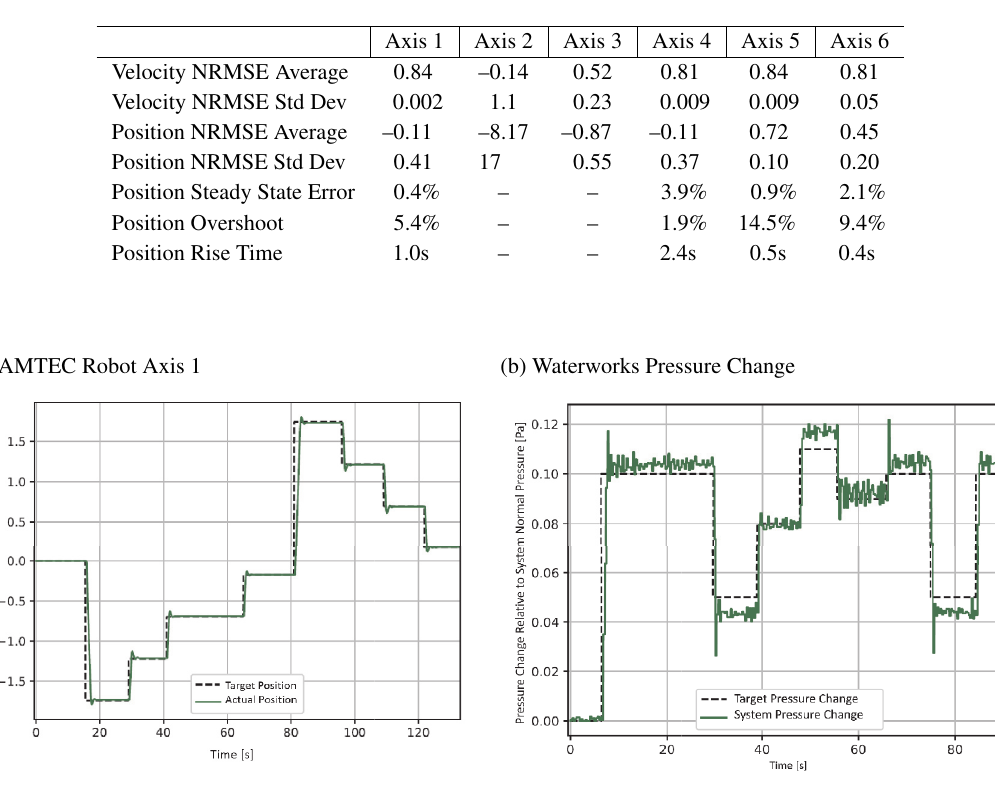
Fig. 3. Position control for Amtec industrial robot t and pressure control for waterwoorks using MPC service with derived from identification service.